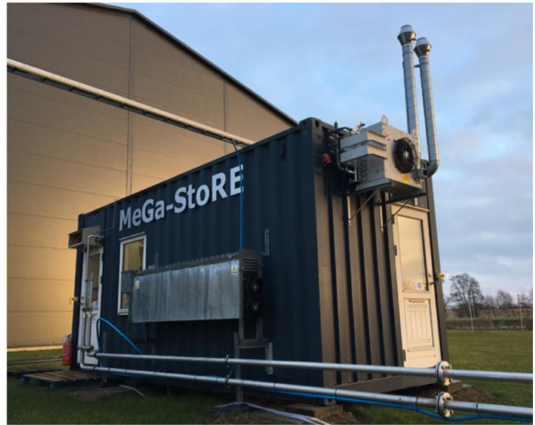
Figure 2. The MeGa-StoRE project container situated at the NGF Nature Energy biogas plant, Midtfyn. In the container, a pilot plant desulfurization and methanation systems are